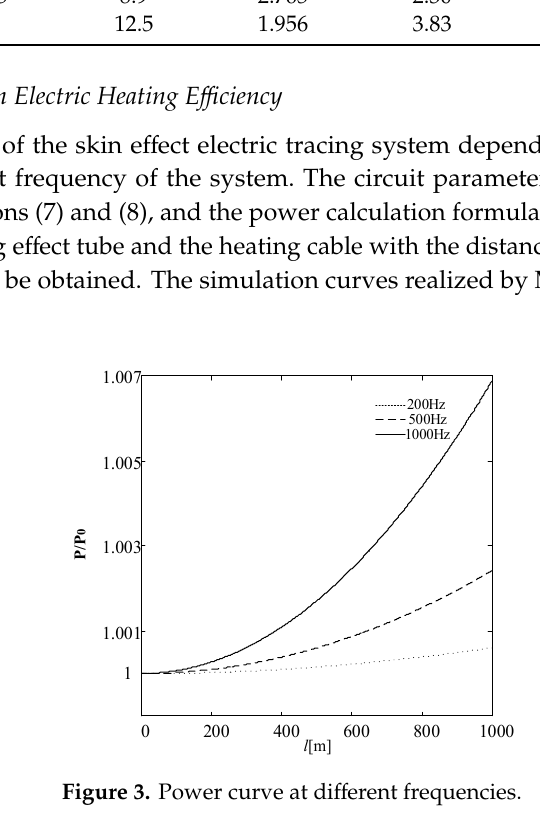
Figure 3. Power curve at different frequencies.